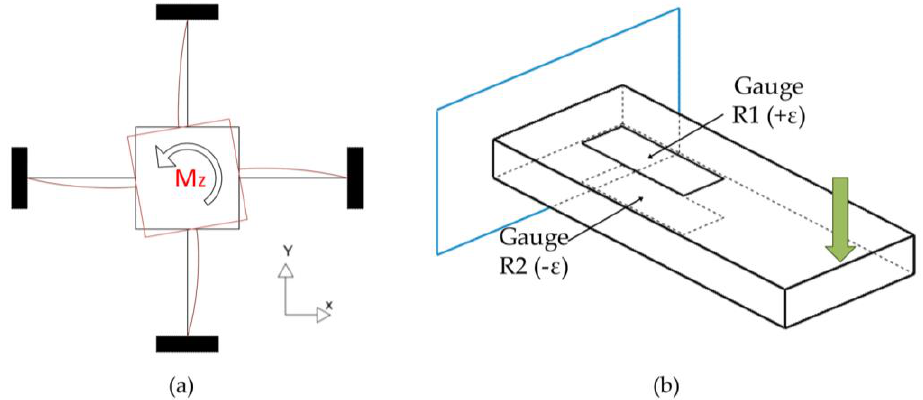
Figure 4. Hub-Sprocket Geometry: ( a ) Beam deformation; ( b ) Attachment of gauges.